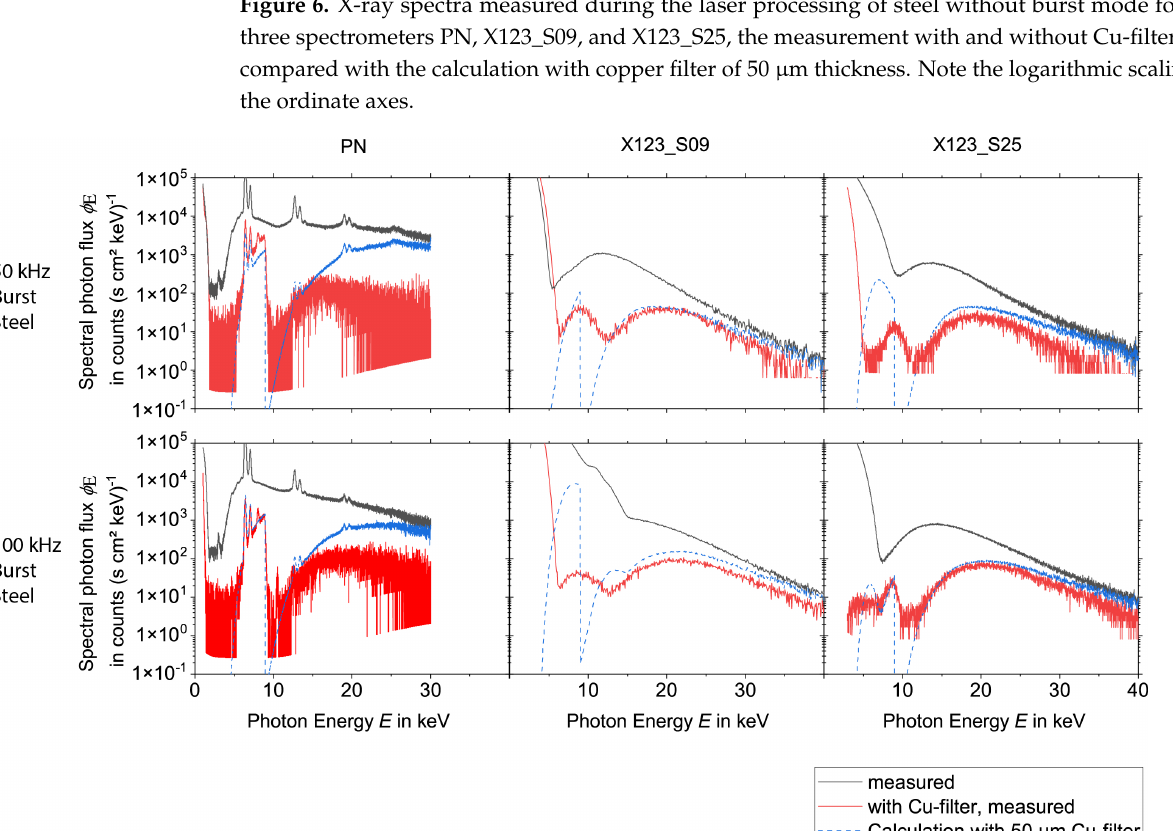
Figure 7. X-ray spectra measured during the processing of steel with burst mode for the three spec- trometers PN, X123_S09, and X123_S25, the measurement with and without Cu-filter was compared with the calculation with copper filter of 50 μ m thickness. Note the logarithmic scaling of the ordi- nate axes.